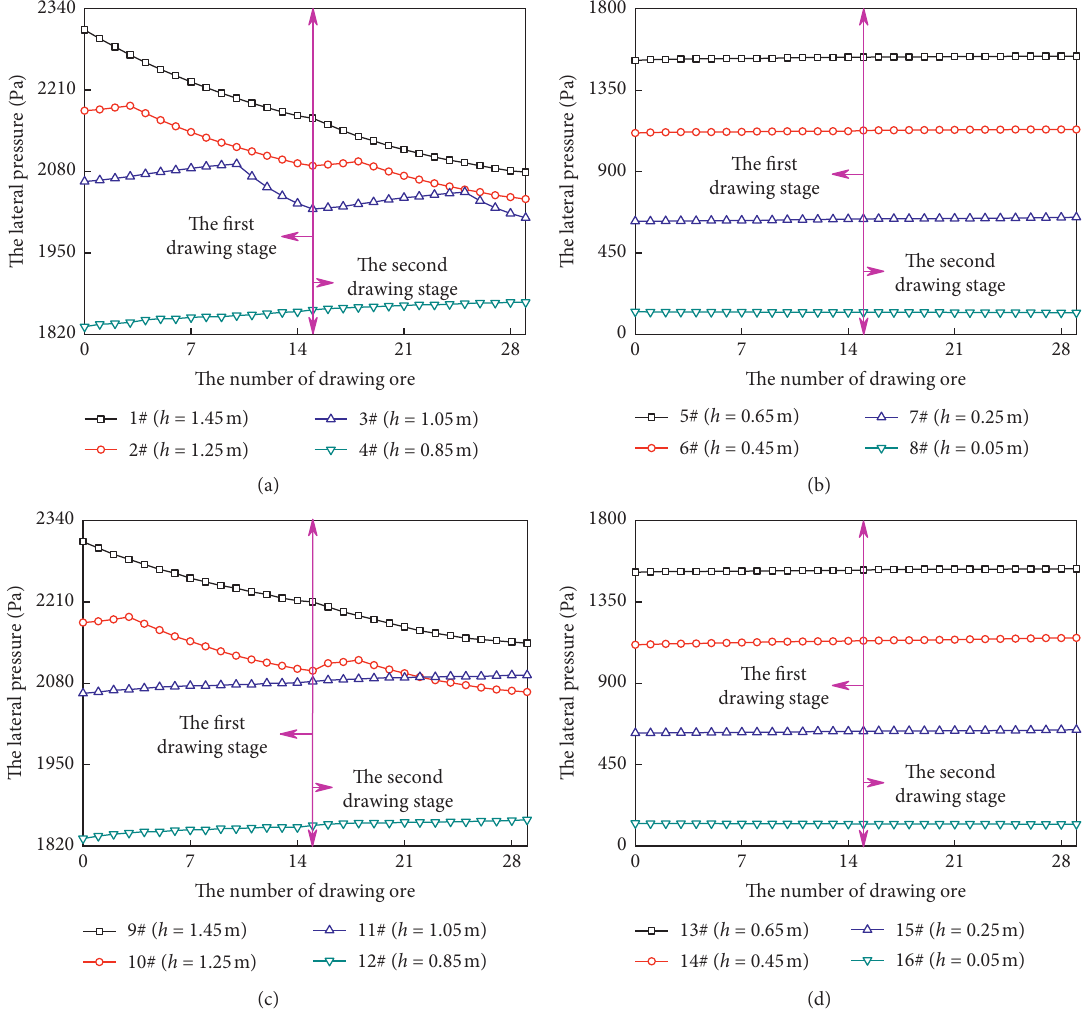
Figure 8: The relationship between the number of drawing ore and the values of lateral pressure with scheme